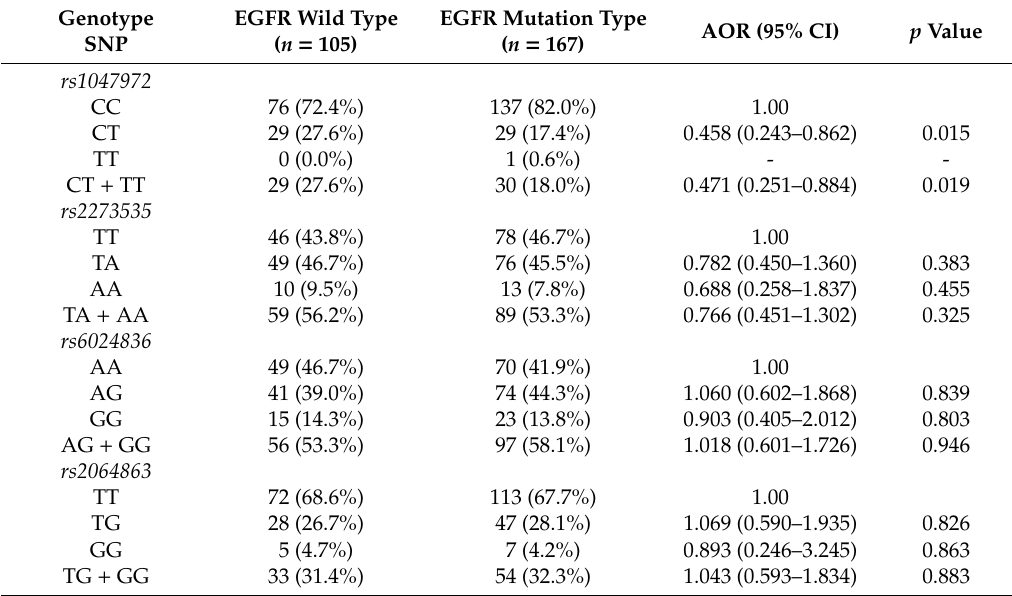
Table 2. Distribution frequency of Aurora kinase A (AURKA) genotypes of lung adenocarcinoma with di ff erent epidermal growth factor receptor